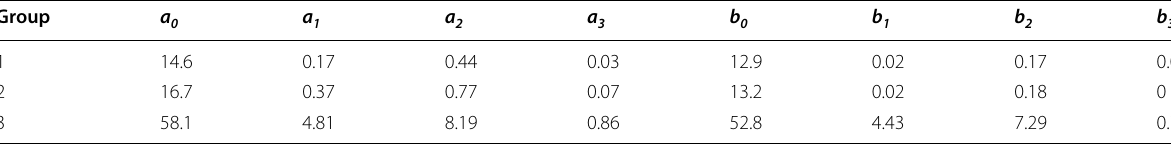
Table 4 Bone-quality coefficients for thread-cutting